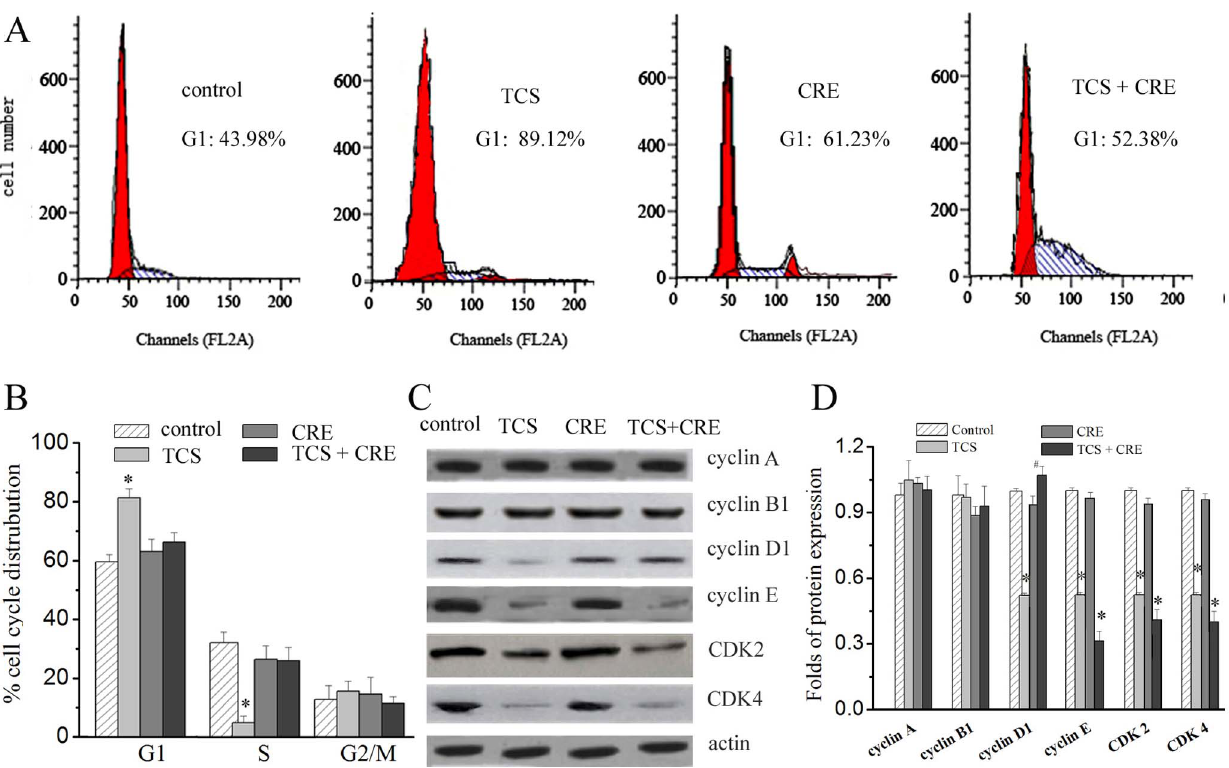
Figure 6. Effects of CRE-decoy on Caski cell cycle progress and regulatory proteins. TCS-induced increase of cell numbers in G1 phase was significantly attenuated by TCS + CRE (A, B). The down-regulated expression of cyclin D1 was reversed by the treatment of TCS + CRE. No effect was observed on other proteins (C, D). Data represent means 6 SD of three independent experiments (* p , 0.05 compared with control, # p , 0.05 compared with TCS).